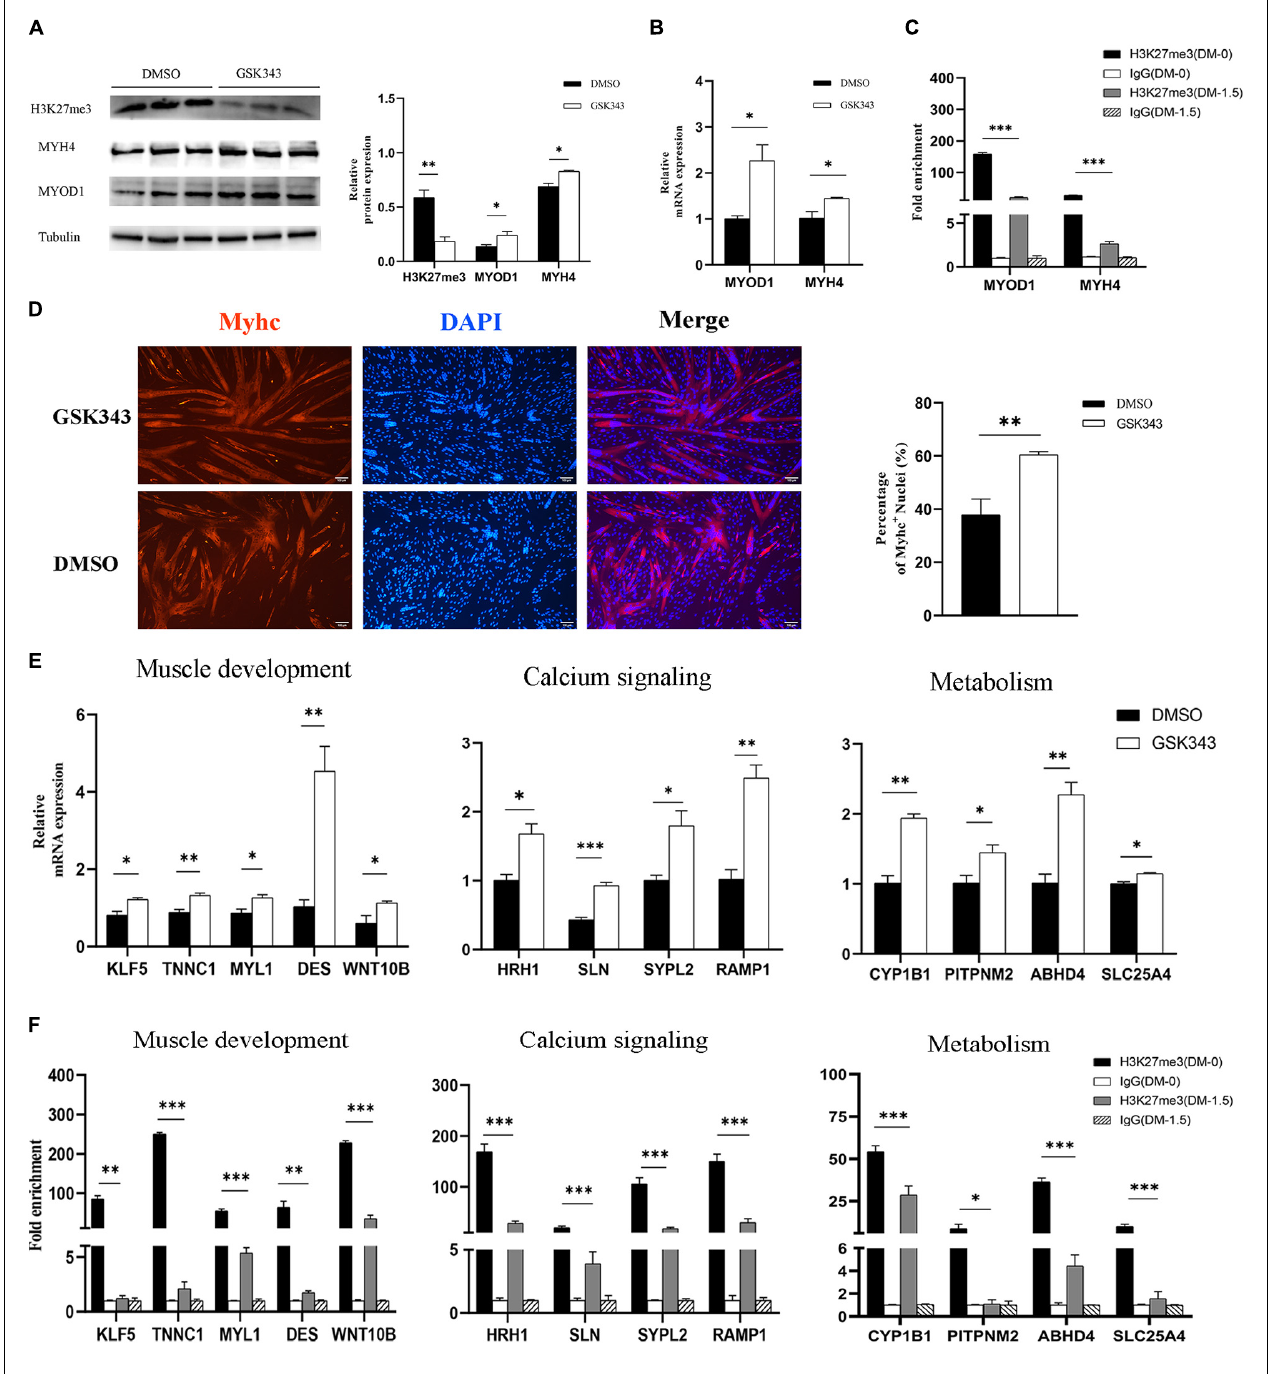
FIGURE 7 | The exploration of H3K27me3 function in muscle development in vitro . (A) Western blotting results showing that the relative protein expression of MYOD1 and MYH4 was increased after GSK343 treatment on day 1.5 post differentiation compared with controls (0.1% DMSO). The protein levels of these genes were quantified using ImageJ software. (B) RT-qPCR results showing that the relative mRNA expression of MYOD1 and MYH4 was increased after GSK343 treatment on day 1.5 post differentiation compared with controls (0.1% DMSO). (C) ChIP-qPCR results showing that the enrichment of H3K27me3 in the MYOD1 and MYH4 were decreased following proliferation to differentiation. (D) Immunofluorescence staining of MYHC showing significant upregulation of PSCs differentiation after GSK343 treatment on day 1.5 post differentiation compared with controls (0.1% DMSO). The number of MYHC + cells was quantified using ImageJ software. (E) RT-qPCR results showing that the mRNA expression of selected HDEGs was increased after GSK343 treatment on day 1.5 post differentiation compared with controls (0.1% DMSO). (F) ChIP-qPCR results showing that the enrichment of H3K27me3 at the promoter of selected HDEGs were decreased following proliferation to differentiation. All values represent the mean ± SEM of three independent experiments. ∗ p < 0.05, ∗∗ p < 0.01, ∗∗∗ p < 0.001, ns indicates not significant.